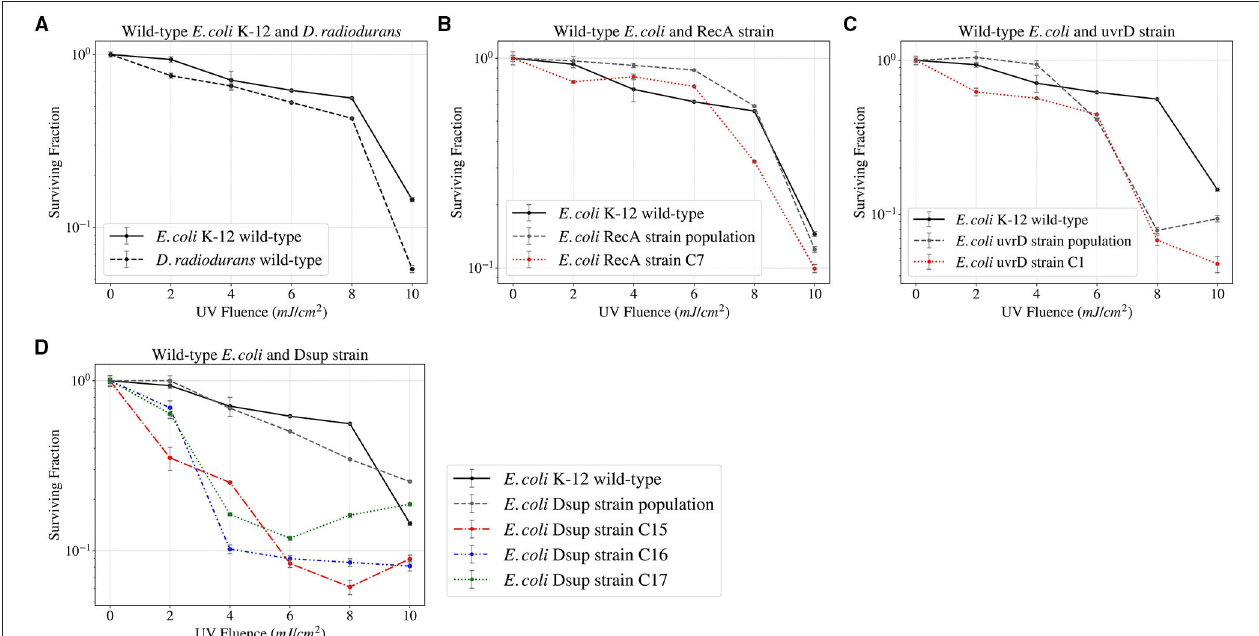
FIGURE 7 | Survival curves of the different E. coli and D. radiodurans strains after UV Fluence exposure up to 785 mJ.